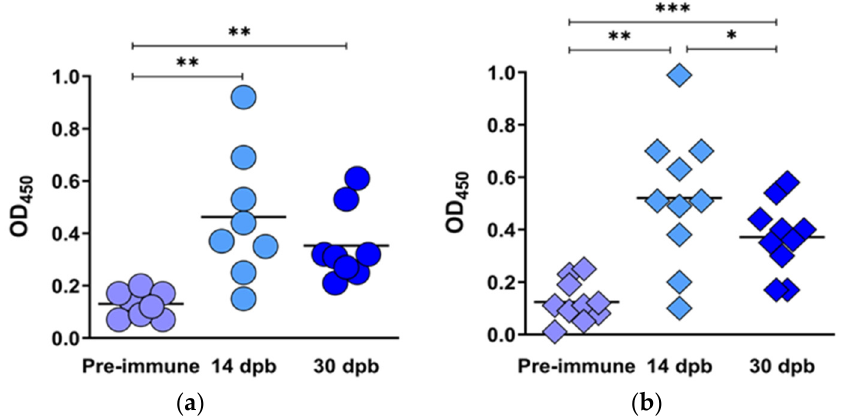
Figure 9. BEFV binding antibody responses elicited by LSDV( ∆ SOD)BEFV-Gb-M (circles) and LSDV(SODis)BEFV-Gb-M (diamonds) in cattle. Sera from the two groups of cattle were tested using a commercial ELISA kit (Unibiotest, Wuhan, China), for binding antibodies to BEFV G protein monomer of Asian lineage. Scatter plots show binding antibody responses to BEFV measured at 450 nm (OD 450 ) in cattle vaccinated with LSDV( ∆ SOD)BEFV-Gb-M ( a ) and LSDV(SODis)BEFV-Gb-M ( b ) at pre-vaccination (lilac), 14 dpb (light blue) and 30 dpb (royal blue). Statistical analyses were conducted using repeated measures one-way ANOVA with Tukey’s multiple comparison test. Horizontal lines indicate median values. * p < 0.05, ** p < 0.01, *** p < 0.001.